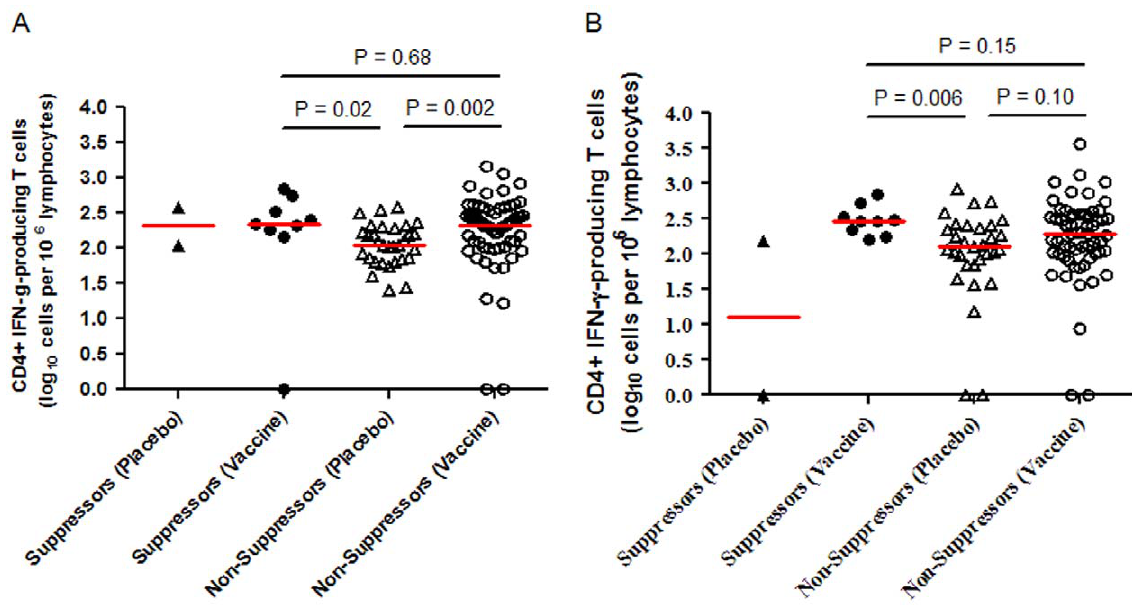
Figure 2. HIV-1 Gag-specific CD4 + IFN- c -producing T cells at weeks 8 and 38 categorized by initial virologic suppression and treatment arm. Panel A, CD4 + IFN- c response 8 weeks after receiving the first vaccine dose. Number of cells quantified by the intracellular cytokine staining assay in response to pooled HIV Gag peptides. Panel B, CD4 + IFN- c response 38 weeks after receiving the first vaccine dose and immediately prior to initiating the analytic treatment interruption. Statistical comparison not provided for participants in the ‘‘Suppressors (Placebo)’’ group as only two participants fell into this category.